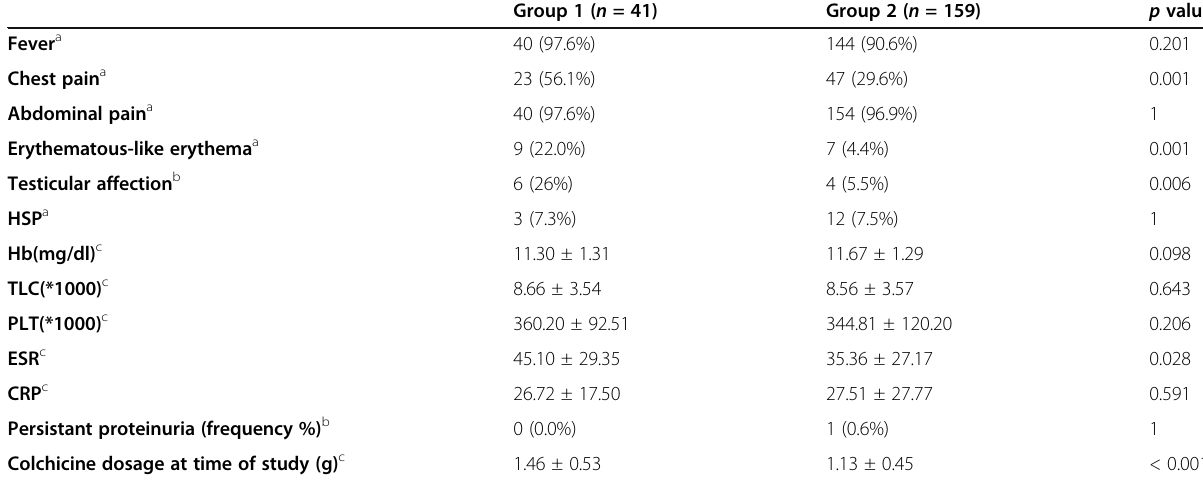
Table 4 Comparison between group 1 and group 2 patients as regards clinical features at the time of the study, laboratory parameters at the time of the disease diagnosis and colchicine